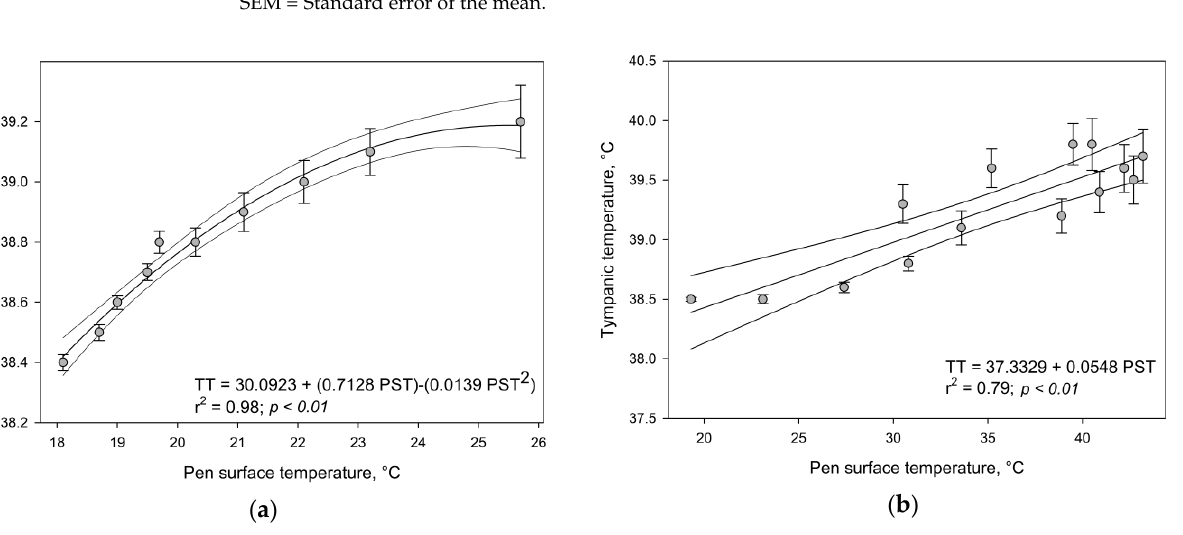
Figure 2. The best fitting equations for predicting tympanic temperature (TT) using pen surface temperature (PST) as a predictor variable ( a ) = nighttime from 2100 to 0600 h, and ( b ) for daytime from 0700 to 2000 h).